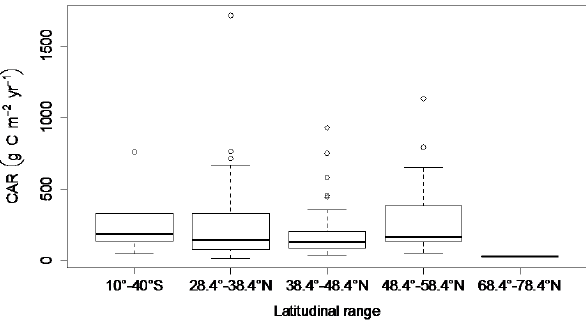
Figure 3. Latitudinal pattern of CAR for global salt marshes. The box-whisker plots of CAR reflect a clear pattern at latitudi- nal range 10–40 ◦ S, 28.4–38.4 ◦ N, 38.4–48.4 ◦ N, 48.4–58.4 ◦ N, and 68.4–78.4 ◦ N, with the highest value in the 48.4–58.4 ◦ N (mean CAR = 315.2gCm − 2 yr − 1 ) , while the lowest value occurs at high- latitudinal 68.4–78.4 ◦ N (mean CAR = 30gCm − 2 yr − 1 ) . No data is available for the 58.4–68.4 ◦ N range and is not presented in the plot. The bottom, middle and top of each box indicates the 25th, 50th (median) and 75th percentiles, respectively. Around 95% of the data are expected to lie between whiskers. The scattered points above the whiskers are outliers and the upper points are extreme